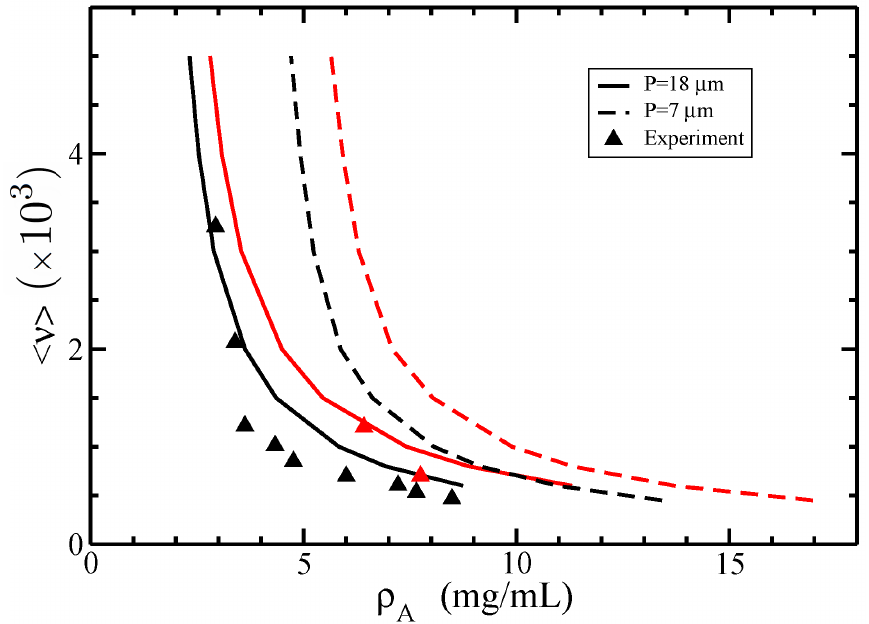
Figure 9. The isotropic–nematic phase diagram in terms of coexisting densities of actin ρ A for different average lengths of filaments < ν > and two values of persistence lengths P = 7 µ m (dashed lines) and P = 18 µ m (solid lines). The normalized standard deviation is σ = 0.5, and the electrolyte concentration c e = 0.1M. The experimental data (triangles) were retrieved from [26]. The coexisting isotropic and nematic densities are plotted in black and red colors,